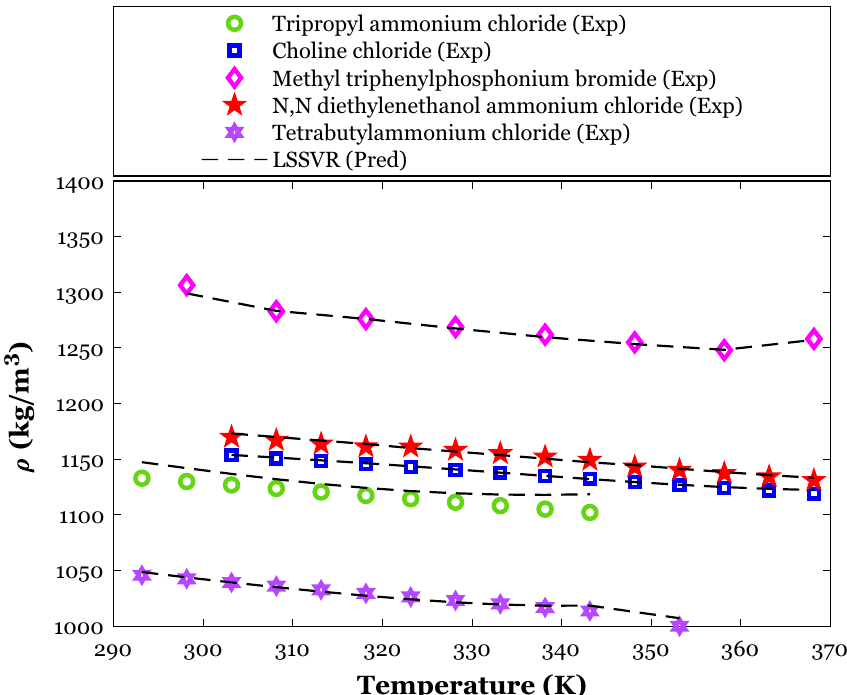
Figure 9. Monitoring the ability of the LSSVR model to anticipate the HBA effect on the density of the glycerol as an HBD.